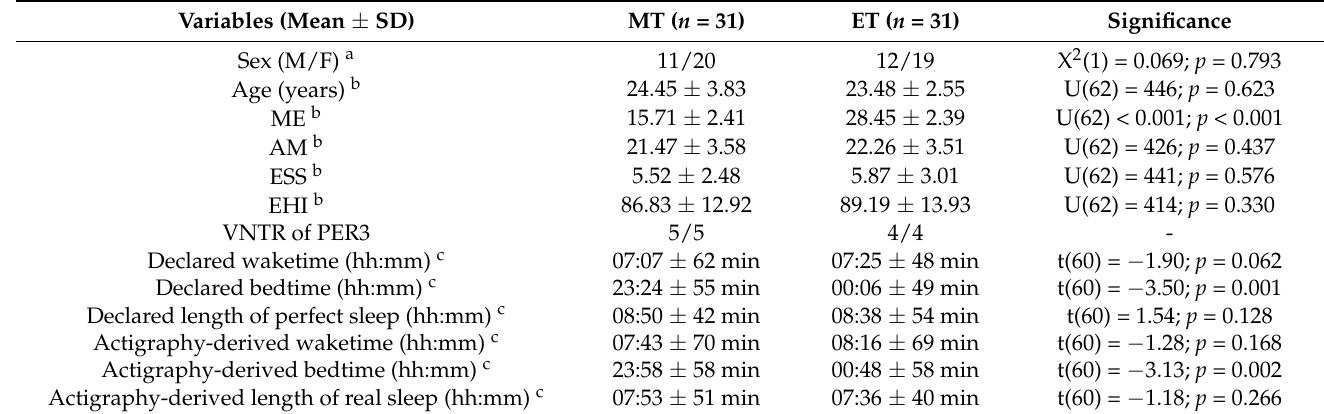
Table 1. Demographics, questionnaires, and actigraphy